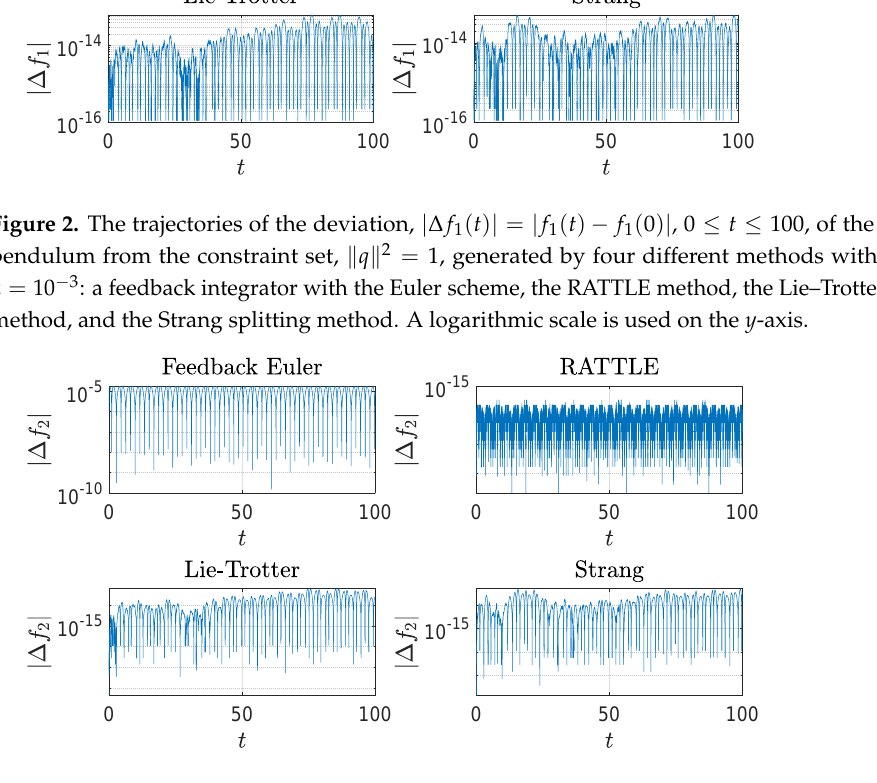
Figure 3. The trajectories of the deviation, | ∆ f 2 ( t ) | = | f 2 ( t ) − f 2 ( 0 ) | , 0 ≤ t ≤ 100, of the spherical pendulum from the constraint set, q · p = 0, generated by four different methods with step size h = 10 − 3 : a feedback integrator with the Euler scheme, the RATTLE method, the Lie–Trotter splitting method, and the Strang splitting method. A logarithmic scale is used on the y